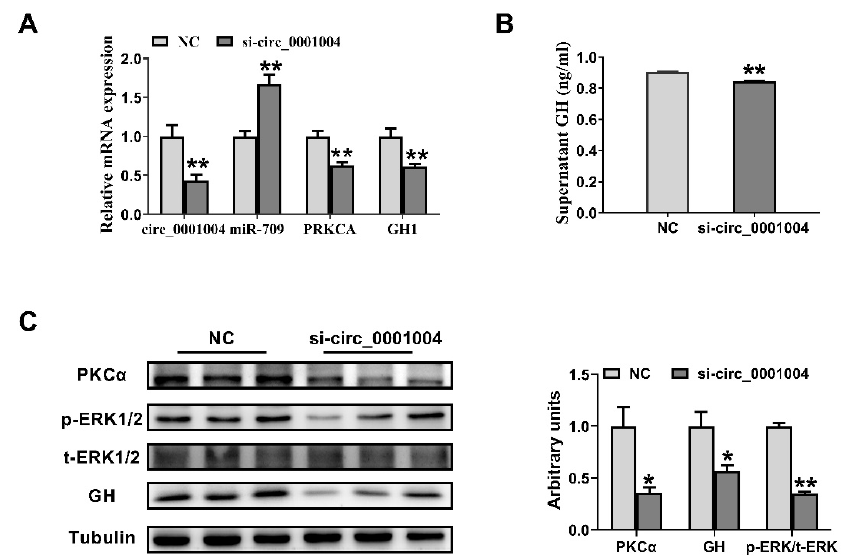
Figure 3. Knockdown of rno_circ_0001004 promoted the GH synthesis and suppressed GH 3 cells. ( A ) The mRNA level of PKCA and GH1 along with circ_0001004 and miR-709 expression after trans- fection si-circ_0001004. ( B ) The changes in supernatant GH level after transfection si-circ_0001004. ( C ) The PKC α , t-ERK1/2, p -ERK1/2 and GH protein expression levels in GH 3 cells after transfection si-circ_0001004. (* p < 0.05; ** p < 0.01).